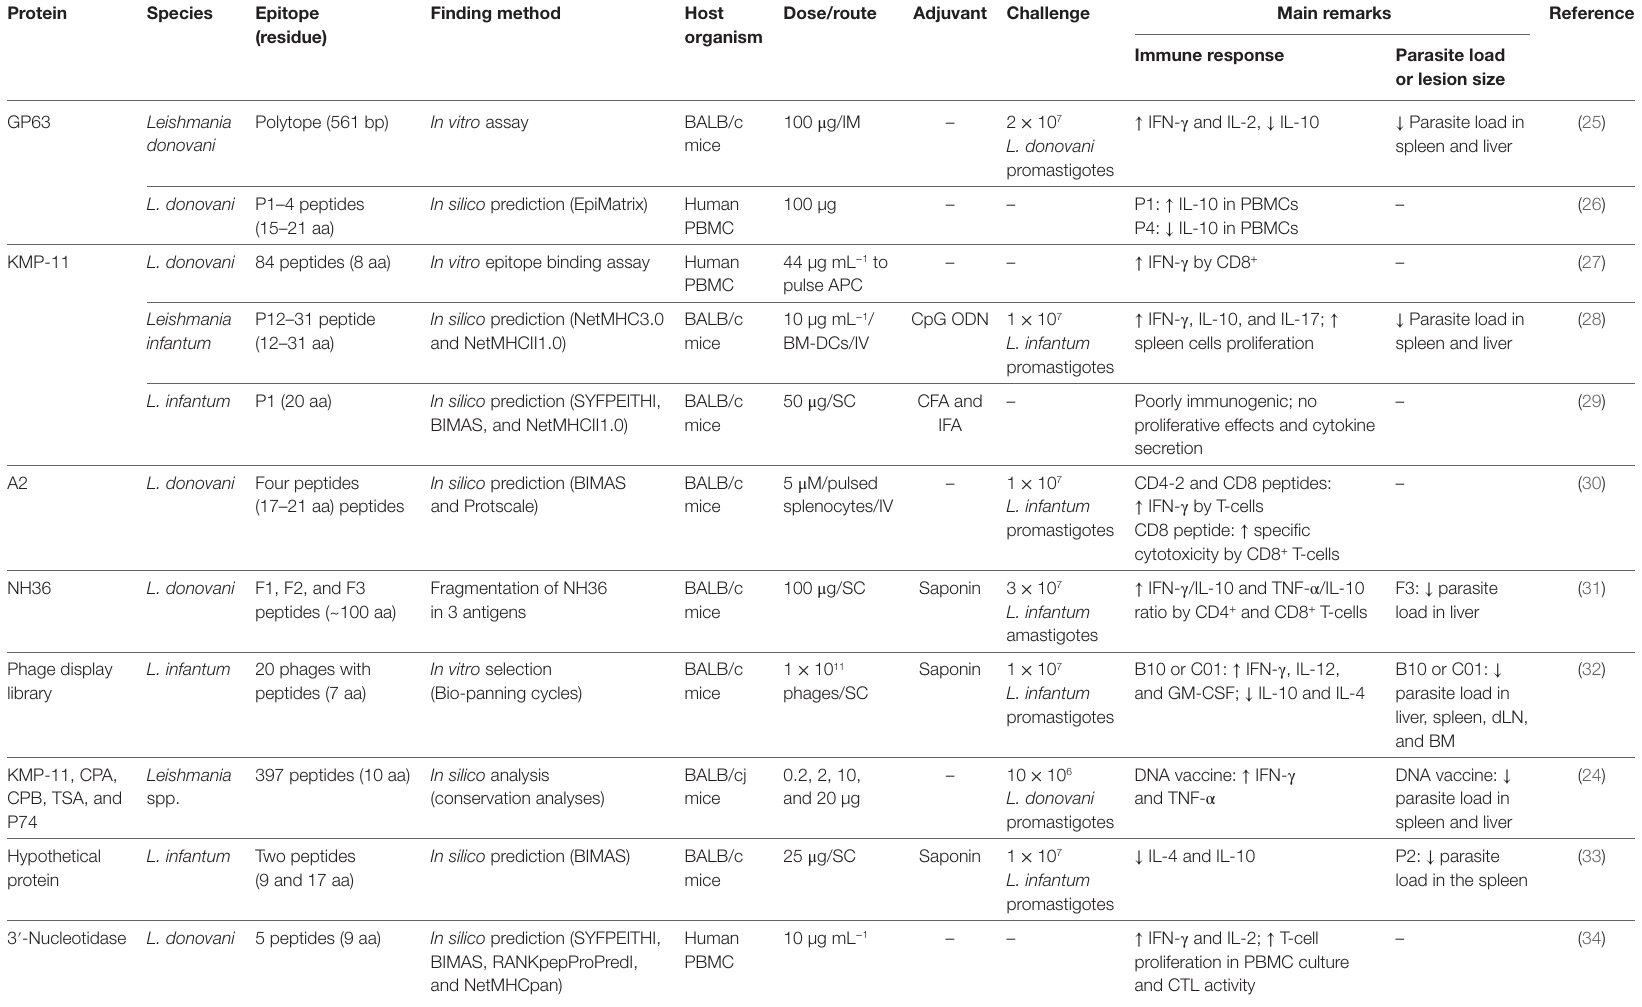
TABLe 1 | Summary of peptides evaluated as potential vaccine candidates against visceral leishmaniasis.